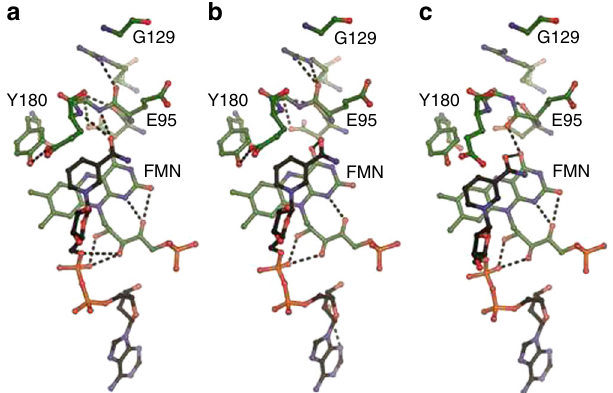
Fig. 3 Nucleotide binding to the complex I. a The structure of the NADH- binding pocket of NuoEF in the reduced state of the protein with bound NADH in the tight position, b that of NuoEF in the reduced state of the protein with bound NAD + close to the tight position and ( c ) that of NuoEF in the oxidized state of the protein with bound NAD + in the loose position No electron density for ordered water was observed between position 129 E and the fi xed peptide bond in the variant as determined with NuoEF. The 3.5 Å distance between O γ of S129 E and the carbonyl oxygen of E95 F is longer than the 3.2 Å from the carboxylate oxygen of D129 E to this position (Fig. 4). Thus, while both mutations fi xed the position of the peptide bond, the Gly/ Asp exchange seemed to exert a much stronger effect than the